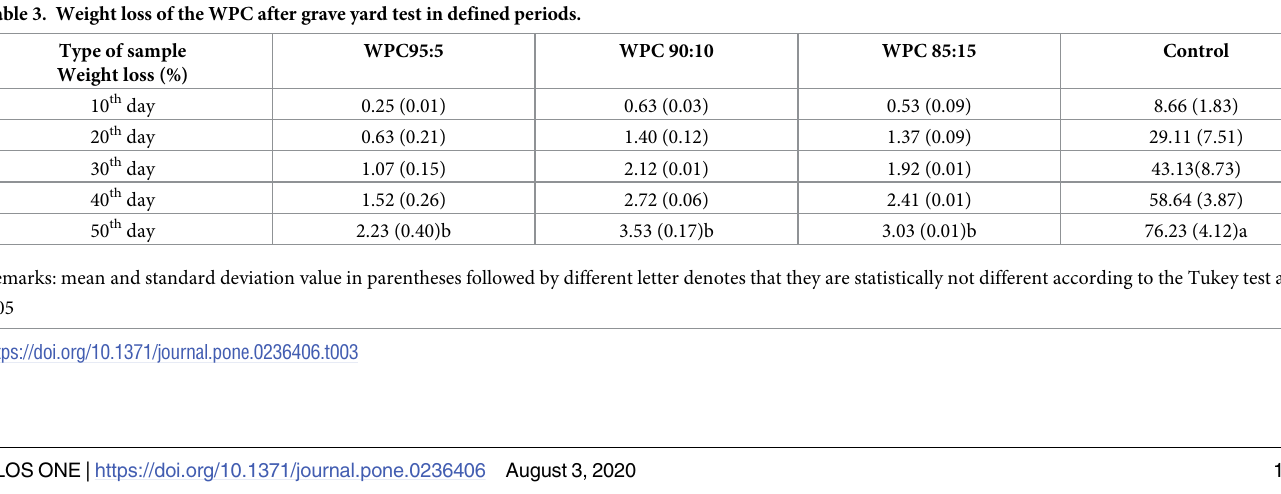
or not. Light microscopy revealed alien objects in the termite guts, suspected to be microplas- tics, as shown in Fig 11. Micro confocal Raman imaging spectrometry revealed that the termite guts contained small amounts of LDPE. The presence of LDPE indicates termites can consume plastics in the form of WPC even though they cannot digest the material. Successful identification of micro- plastics using this method has been reported by Karami et al. [52,53] in dried fish and com- mercial salts. In this study termite guts were prepared and observed either wet or dry and at both micro and macro resolution. Both the wet measurement process and the micro technique were unsuccessful (the spectra were not found) in identifying LDPE because of very low con- centration of LDPE inside the termite guts. Fortunately, the dry measurement process and